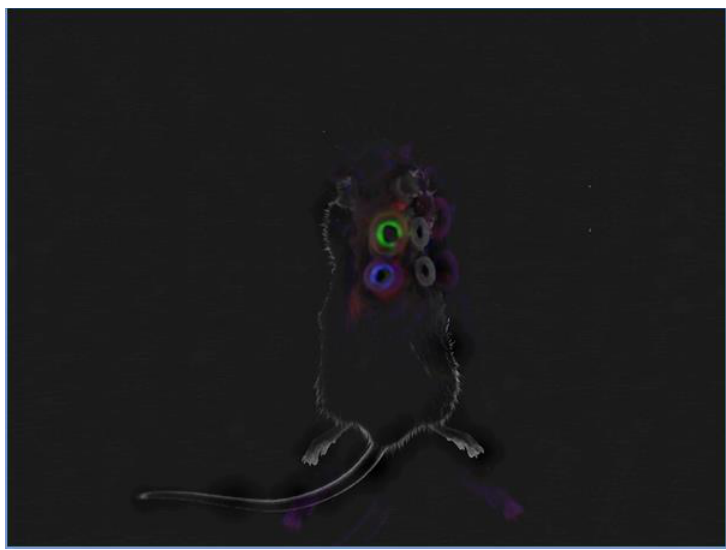
Figure 2. The uptake of siRNA in the wound area. Left side: 6-FAM-labeled non-targeting control siRNA (green), and Cy3-labeled anti-cyclophilin B control siRNA (blue); right side: PBS treatment. A fluorescent signal indicates the uptake of siRNA by the cells in the wound area. No signal is observed in the PBS control group. Analysis was performed using the Azure 400 system.